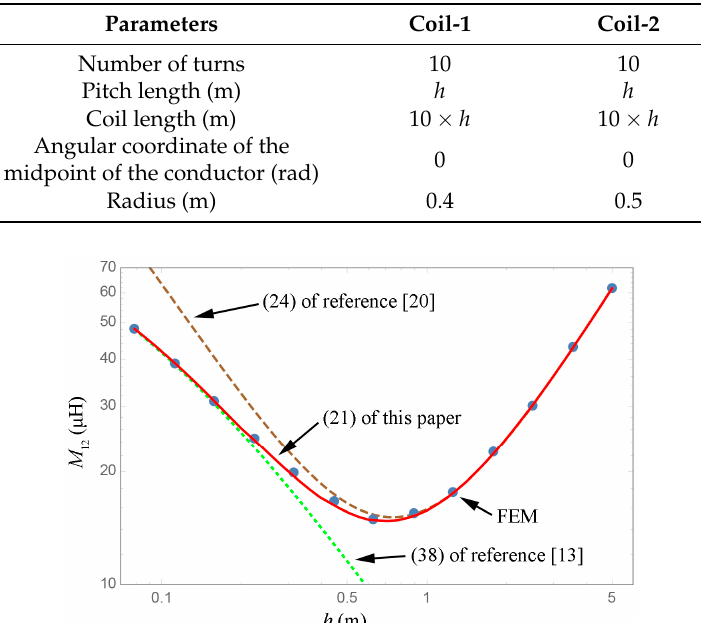
M ). Figure 8. Pitch length ( h ) dependence of the mutual inductance ( M 12 12 M ). 12